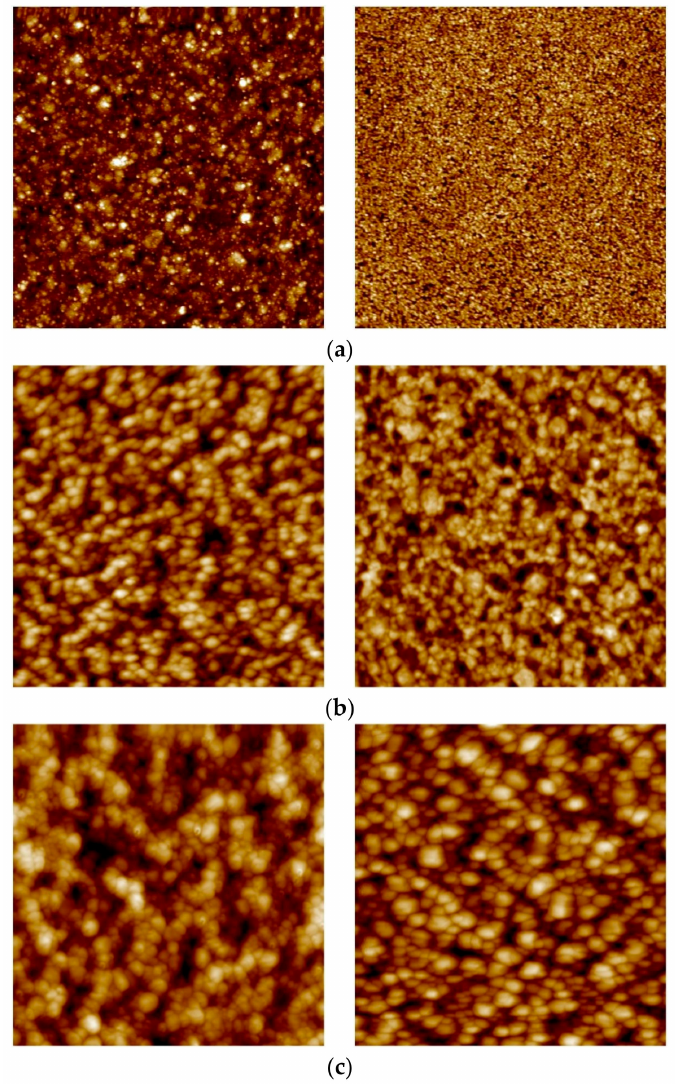
Figure 5. AFM images of the 2.2 µ m thick membrane for the feed/growth side (left panel) and permeate/substrate side (right panel) for ( a ) as-grown; ( b ) hydrogen stabilized; and ( c ) HTA-subjected samples. Image areas: ( a ) right: 1 × 1 µ m 2 ; rest: 5 × 5 µ m 2